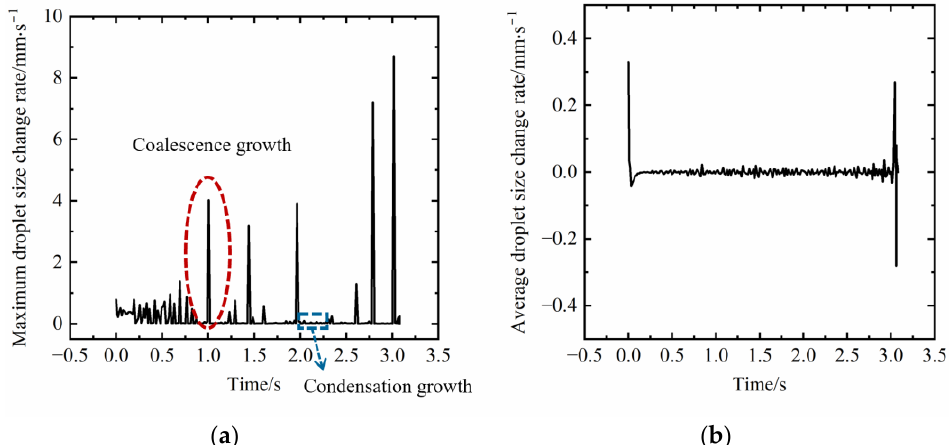
Figure 10. Comparison of change rate of maximum droplet size and average droplet size; ( a ) Maximum droplet size change rate and ( b ) Average droplet size change rate.